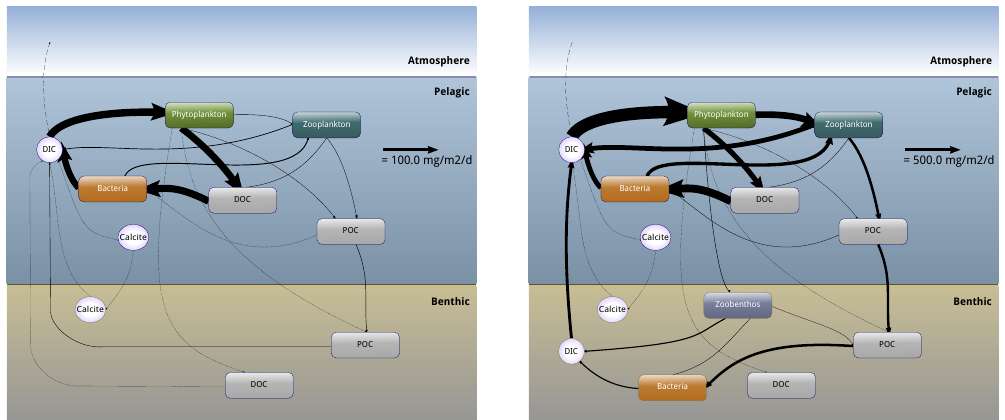
Figure 6. Carbon fluxes in ERSEM under oligotrophic (left panel) and eutrophic (right panel) conditions. The flux amount is proportional to arrow thickness. (Note the different scales of the arrow